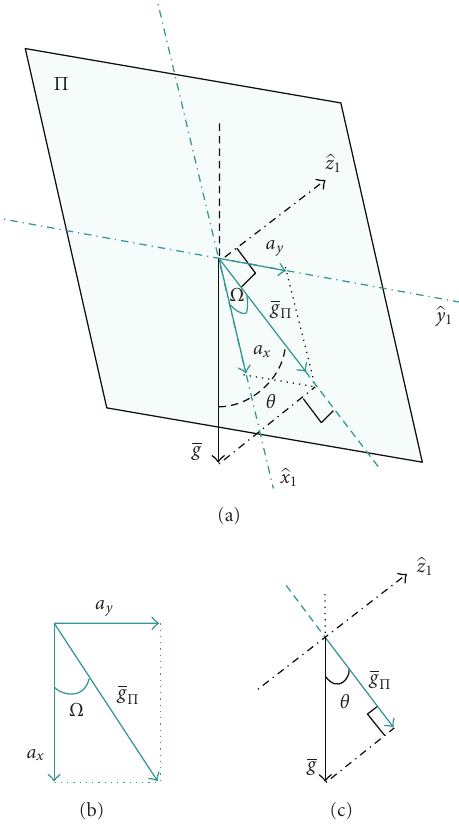
Figure 5: Measuring tilt from two acceleration